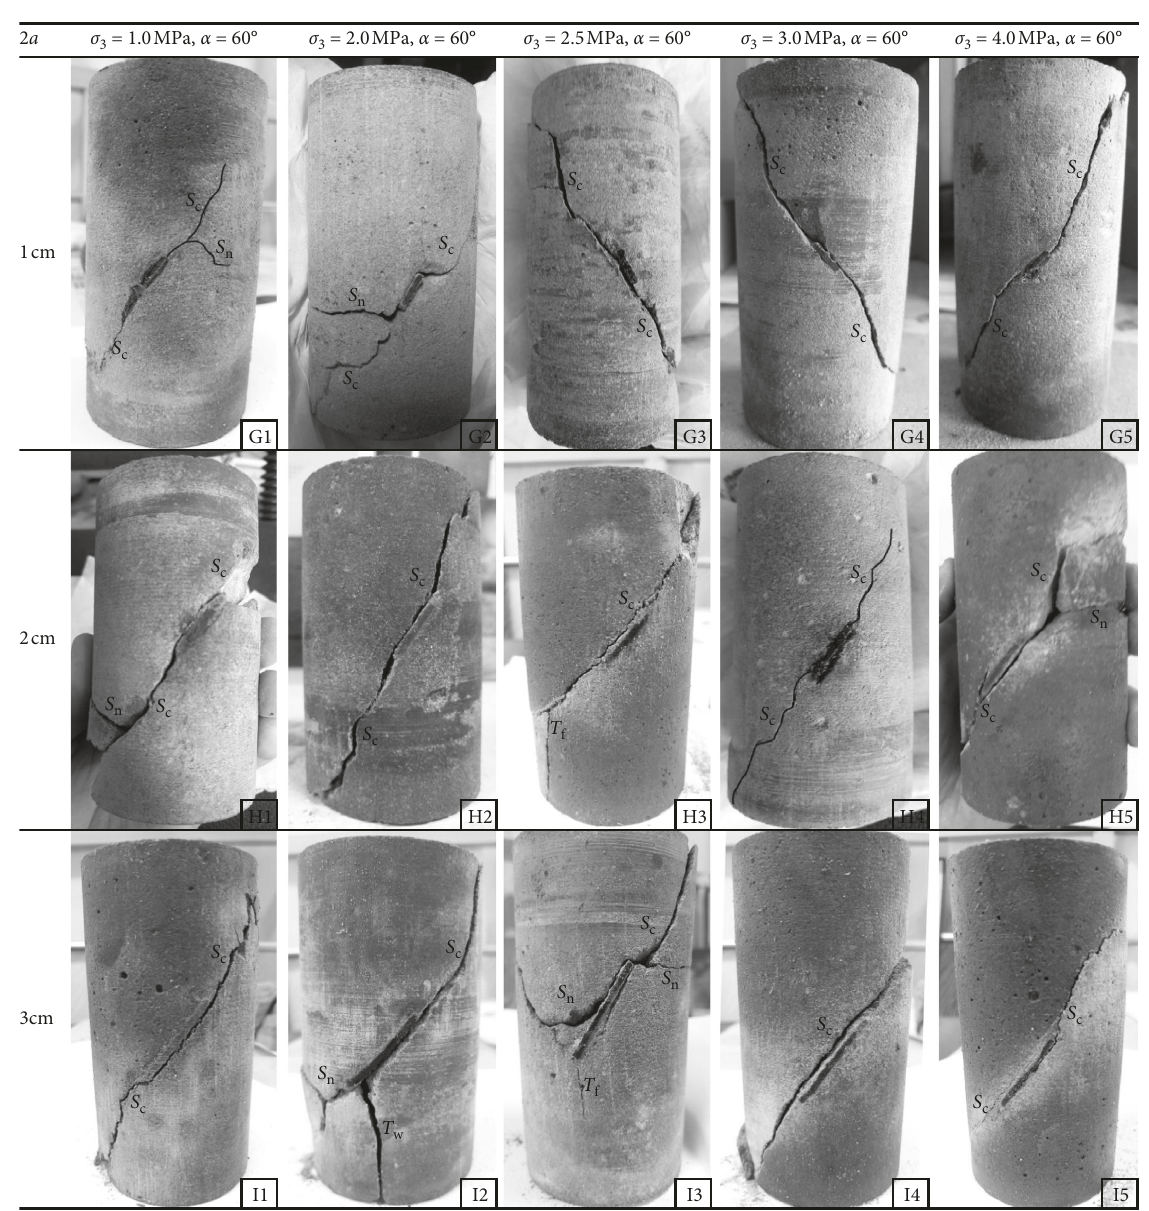
Figure 7: Failure modes of the specimens with a grout-infilled flaw having an inclination angle of 60 ° and different flaw